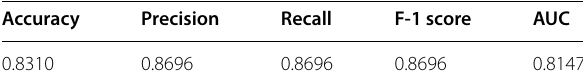
Table 8 Two-class classification performance obtained by